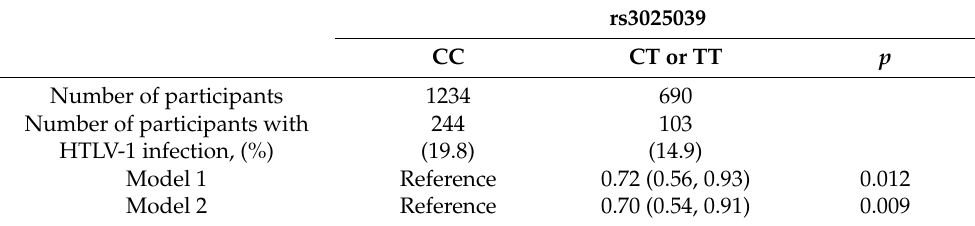
Table 3. Association between carrier of rs3025039 allele (T) and HTLV-1.